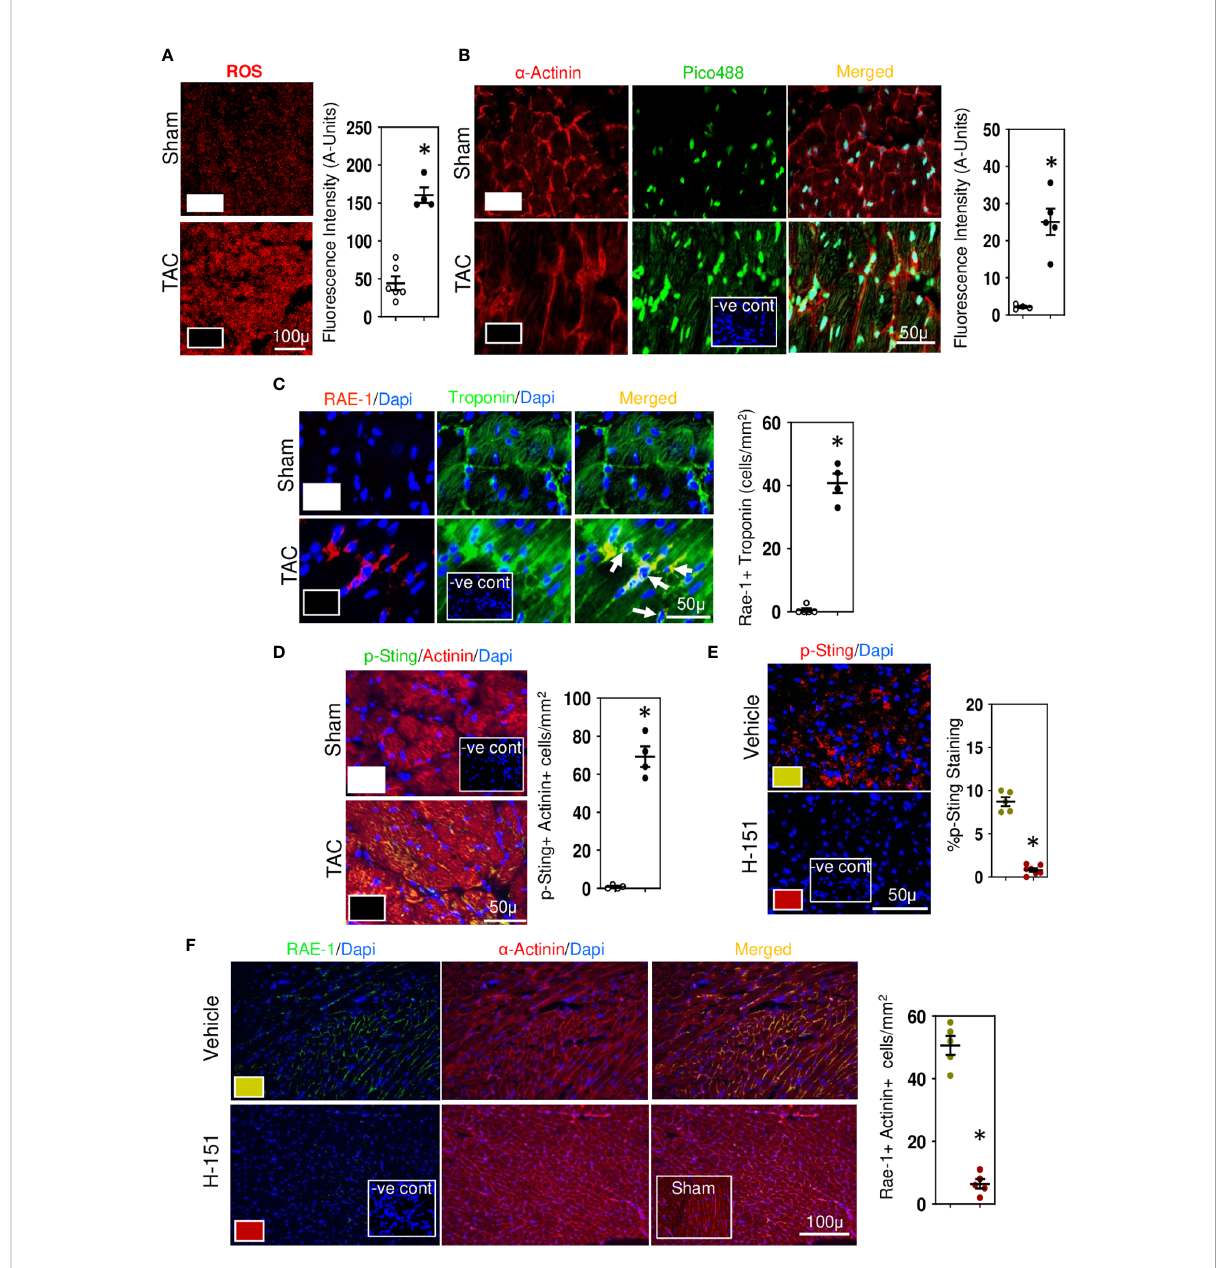
FIGURE 5 Cytosolic DNA and STING in stressed cardiomyocytes initiates the fi brotic signaling cascade. (A) Representative photomicrographs demonstrating increases in ROS in LV of TAC mice. (B) Photomicrographs demonstrating increases in cytosolic DNA in cardiomyocytes of TAC mice detected with Pico488. Representative photomicrographs demonstrating increases in RAE-1 expression in cardiomyocytes (C) together with increased phosphoSTING (D) during TAC-induced hypertension. Treatment with H-151, anti-STING small molecular inhibitor, reducesphosphoSTING expression (E) and prevents cardiomyocyte expression of RAE-1 expression (F) in LV of TAC mice. Results are means ± SEM with small circles representing data from individual mice. n=7-9/group. -ve control; no primary antibody control, sham; sham-operated, scale bar represents either 100µm or 50µm. *P<0.05 using two tailed Student ’ s t-test test comparing to either TAC or